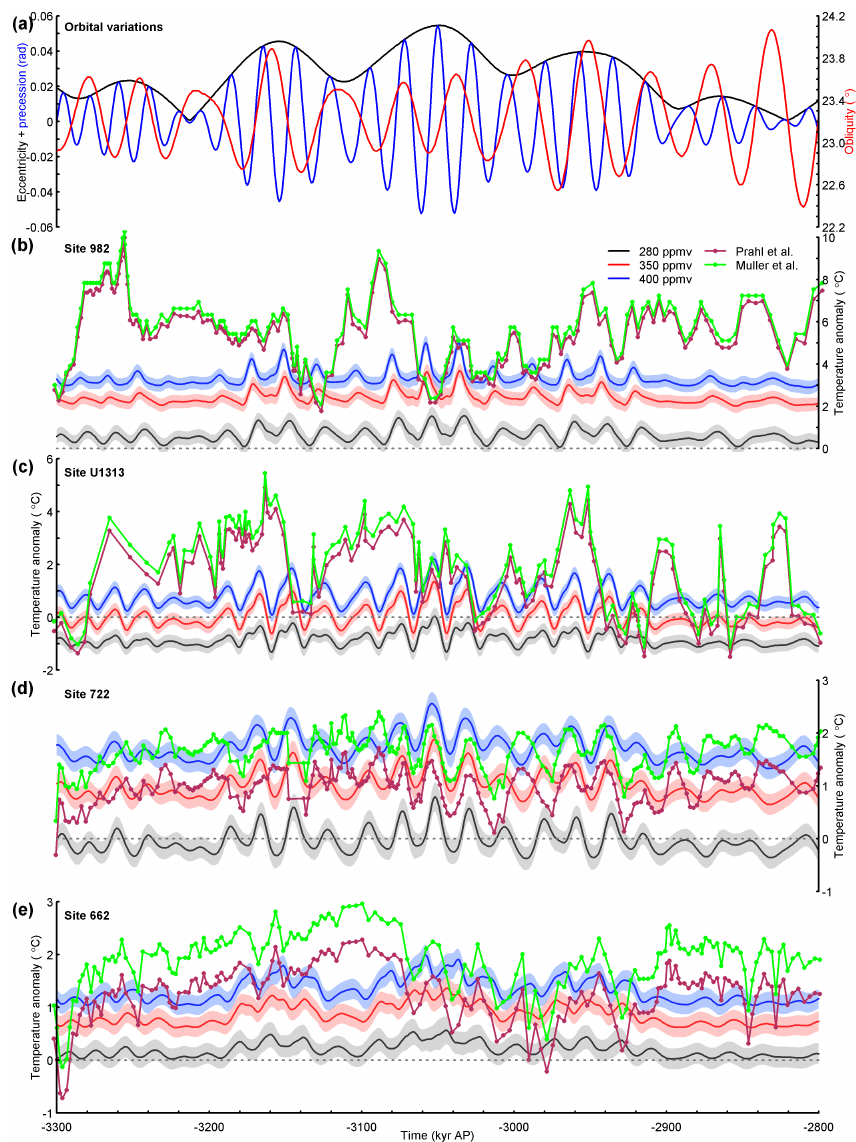
Figure 10. Data–model comparison of temperature anomaly for the period 3300–2800kyrBP (late Pliocene). (a) Time series of orbital variations (Laskar et al., 2004), showing eccentricity (black) and precession (radians, blue) on the left axis and obliquity (degrees, red) on the right axis. (b) – (e) Time series of emulated grid box mean annual SAT ( ◦ C, plain lines), modelled every 1kyr, for three constant CO 2 scenarios: 280ppmv (black), 350ppmv (red) and 400ppmv (blue). Modelled using the lowice emulator. Error bands represent the emulated grid box posterior variance (1SD). Also shown are SST proxy data ( ◦ C, dotted lines) calibrated using the method of Prahl et al. (1988) (maroon) and the method of Muller et al. (1998) (green). SSTs for four ODP/IODP sites are compared: Site 982 (North Atlantic; Lawrence et al., 2009), Site U1313 (North Atlantic; Naafs et al., 2010), Site 722 (Arabian Sea; Herbert et al., 2010) and Site 662 (tropical Atlantic; Herbert et al., 2010). SAT is shown as an anomaly compared with the pre-industrial control simulation, SST is shown as an anomaly compared with SST observations for the period 1870–1900 taken from the HadISST data set (Rayner et al., 2003). Note the different vertical axis